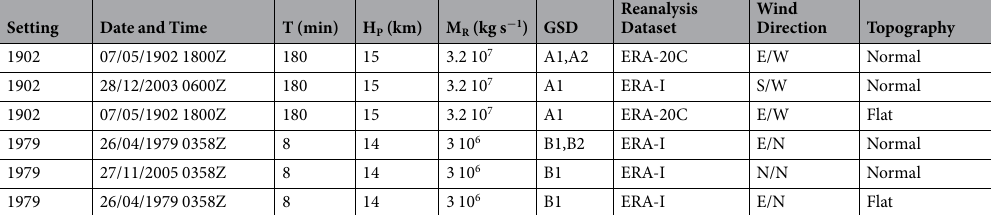
Table 1. Experimental setting description. The columns tabulate the following: (1) eruption setting; (2) date and time of the eruption initiation; (3) eruption duration, T ; (4) plume height H P ; (5) mass eruption rate, M R ; (6) grain size distribution used, GSD (see Supp. Table 3 for details); (7) reanalysis dataset used; (8) wind direction below/above inversion (at ~5 km above sea level); (9) state of topography in the